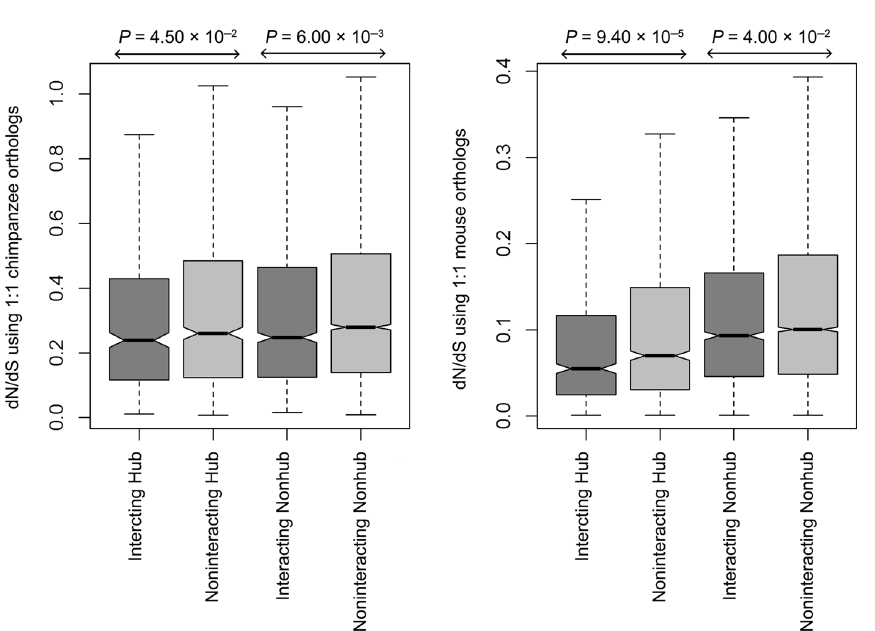
Figure 3. Evolutionary rate (dN/dS ratio) of pathogen-interacting and noninteracting human proteins within hubs and nonhubs using 1:1 chimpanzee and mouse